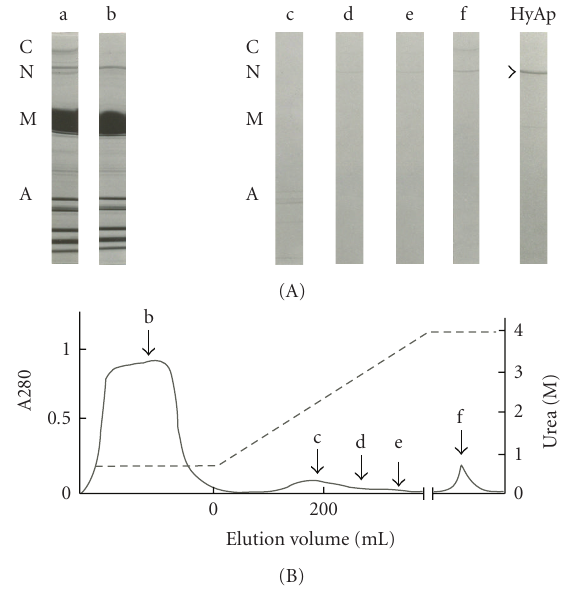
Figure 1: Purification of nebulin from rabbit skeletal muscle by DEAE-Toyopearl column chromatography. A muscle extract in 0.18 M KPO 4 (pH 7.0), 0.2 mM ATP, 0.1 mM MgCl 2 , 0.1 mM EGTA, and 1M urea was loaded to DEAE-Toyopearl column and linear urea gradient up to 4M was applied. (A) SDS-PAGE patterns of each fraction of (B), (B) Elution pattern. a, applied sample; b, flow- through fraction; c–e, eluted fraction; f, overnight fraction with 4M urea; HyAp, purified nebulin using hydroxylapatite column